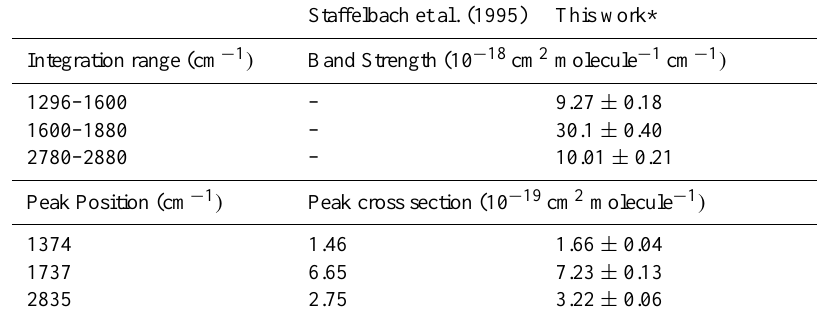
Table 1. Infrared absorption band strengths and peak cross sections of methylglyoxal, CH 3 COCHO, measured in this work at